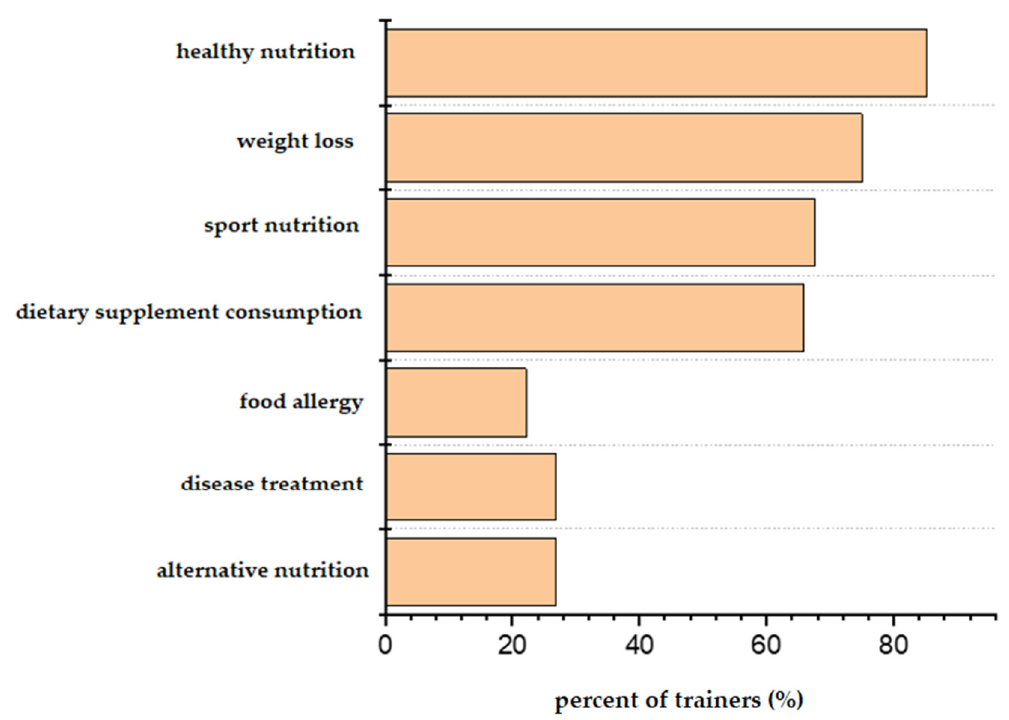
Figure 4. Content of nutrition-related advisory and counselling activity of trainers (percent ratio of trainers mentioning the content as a part of their counselling activity).